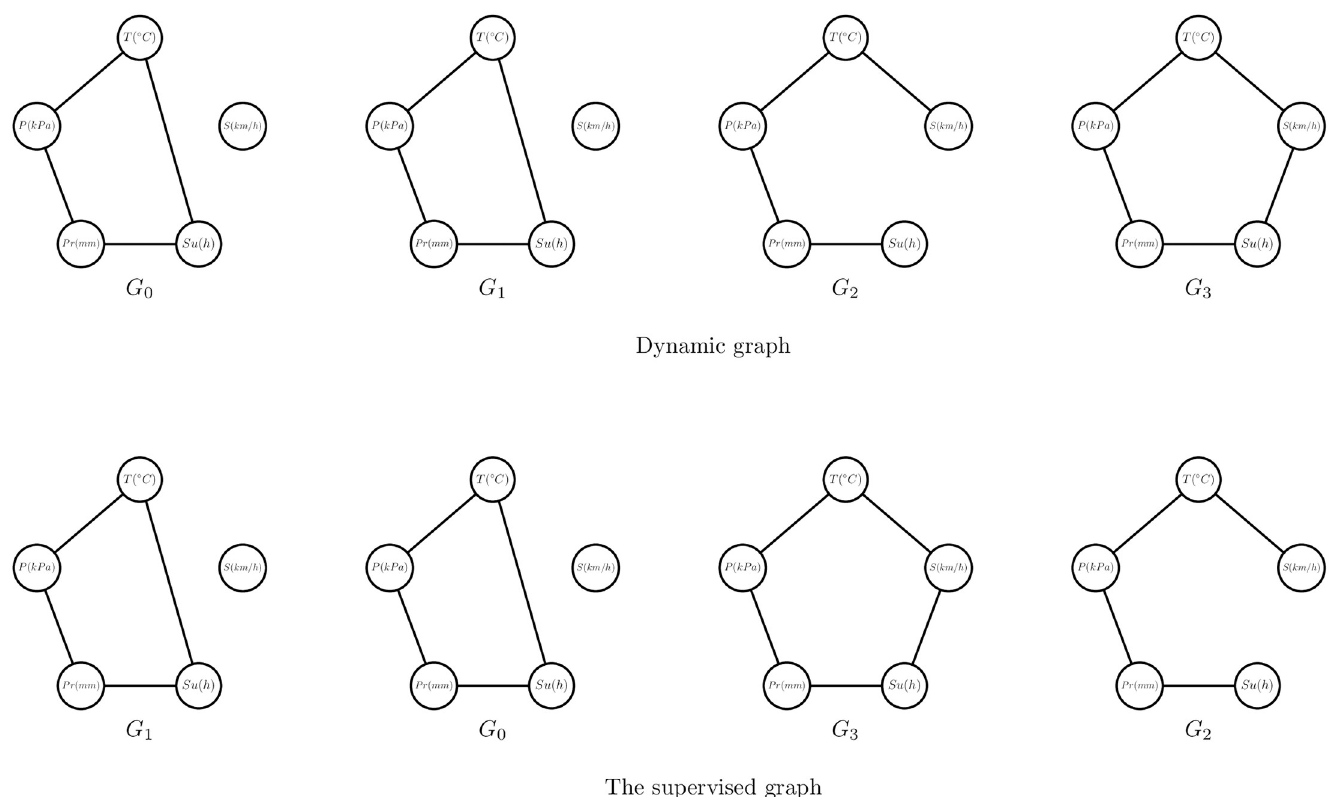
Fig 3. Example of the dynamic supervised